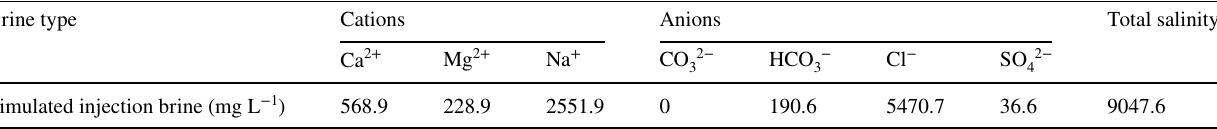
Fig. 2 Molecular structure of the polymer–surfactant ( X, Y are func- tional groups by graft copolymerization) Table 1 Composition of the simulated injection brines Brine type